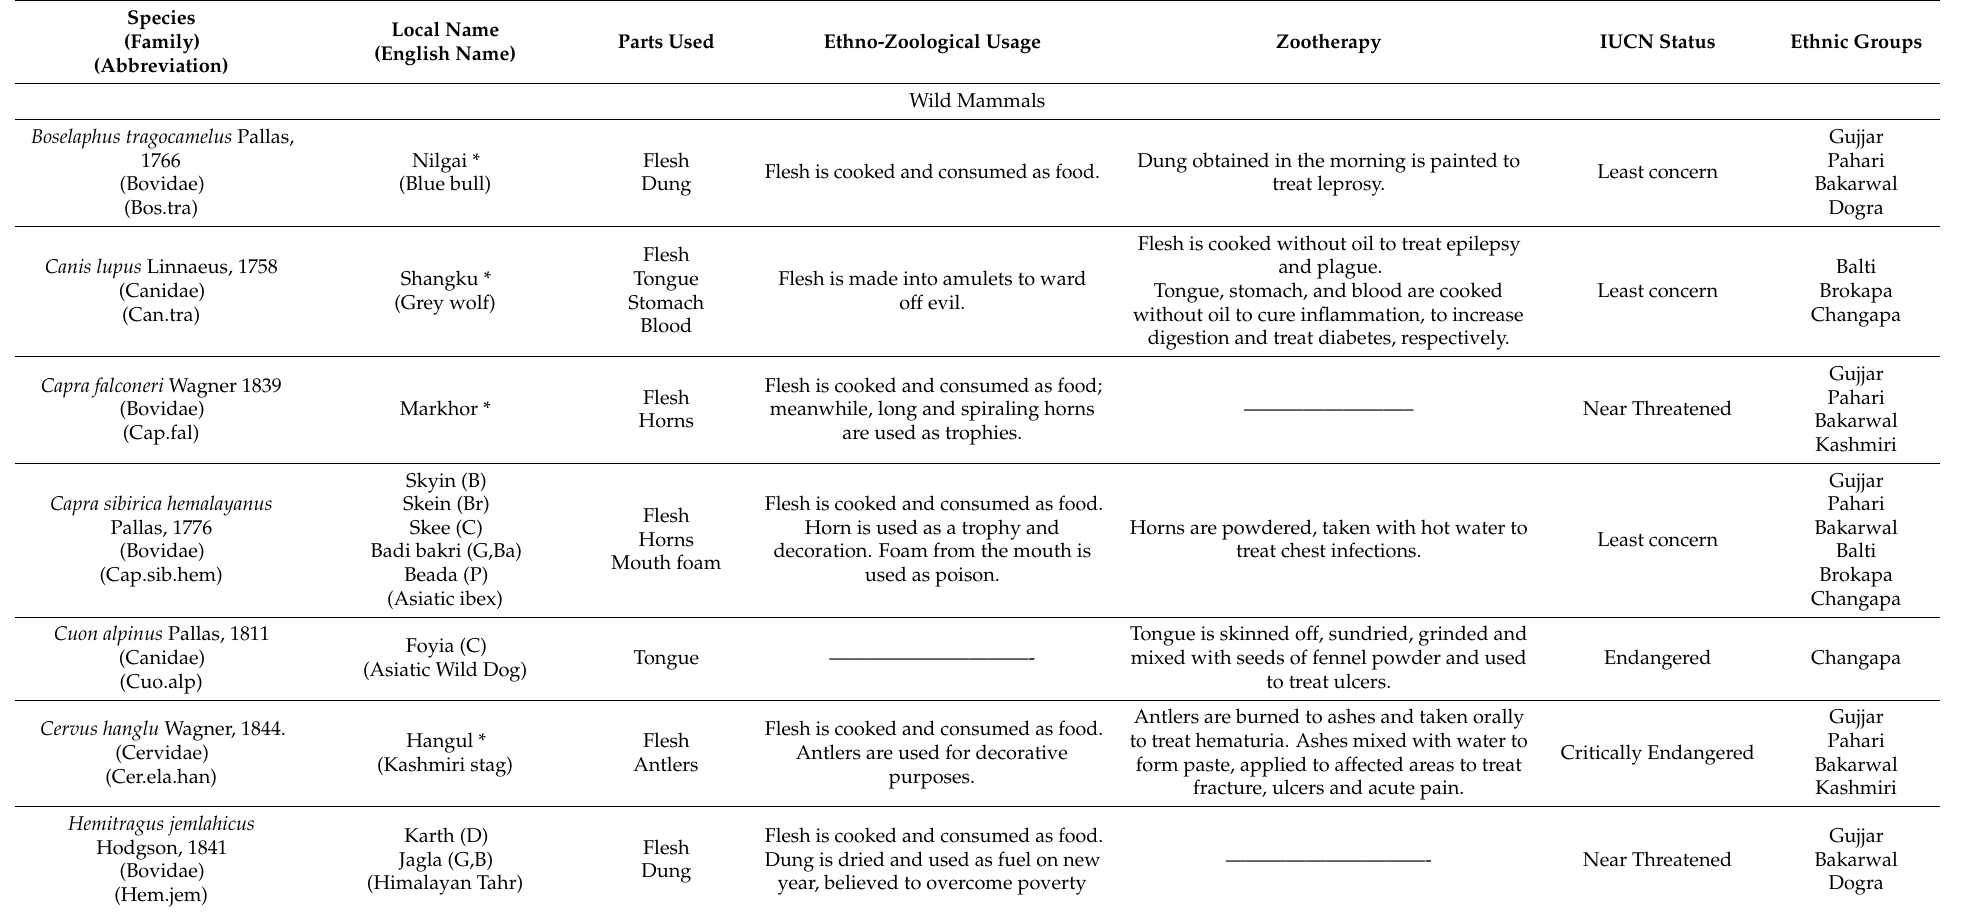
Table 2. Ethnozoological inventory of documented